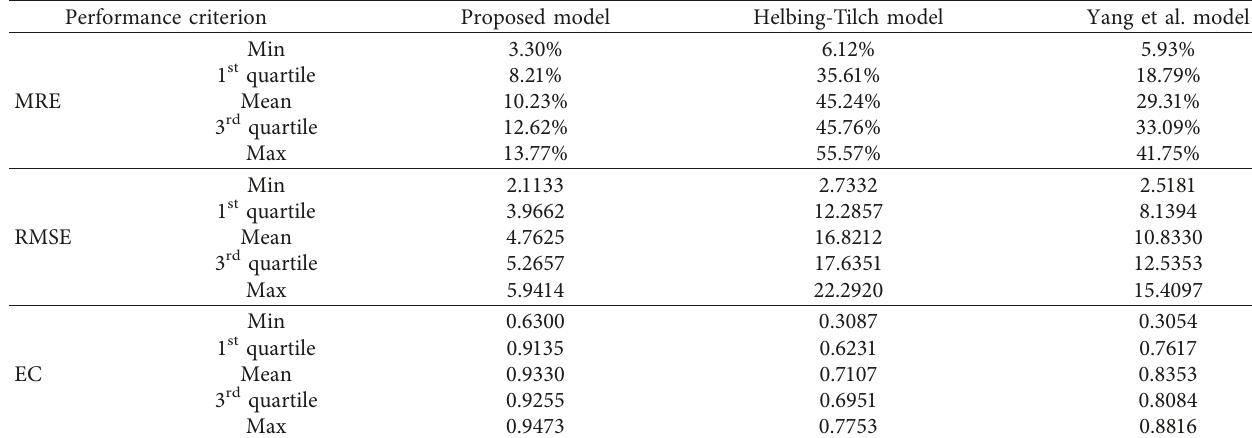
Table 8: Summary of model validation